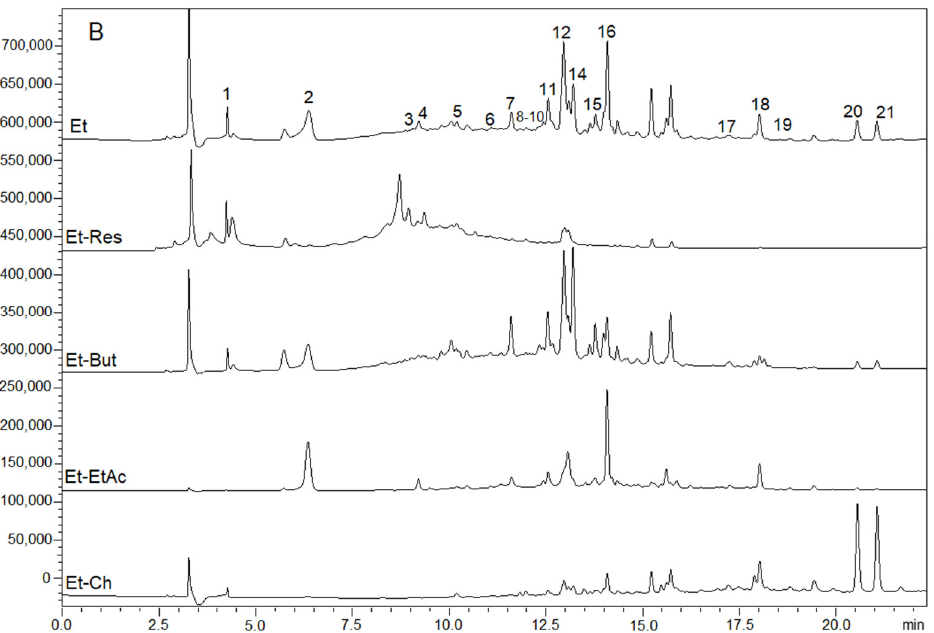
Figure 2. HPLC chromatographic profile of aqueous extract (Aq) and aqueous solvent fractions: chloroform (Aq-Ch), ethyl acetate (Aq-EtAc), n -butanol (Aq-But), and residual fraction (Aq-Res) ( A ); HPLC chromatographic profile of ethanolic extract (Et) and ethanolic solvent fractions: chloroform (Et-Ch), ethyl acetate (Et-EtAc), n -butanol (Et-But), and residual fraction (Et-Res) ( B ).